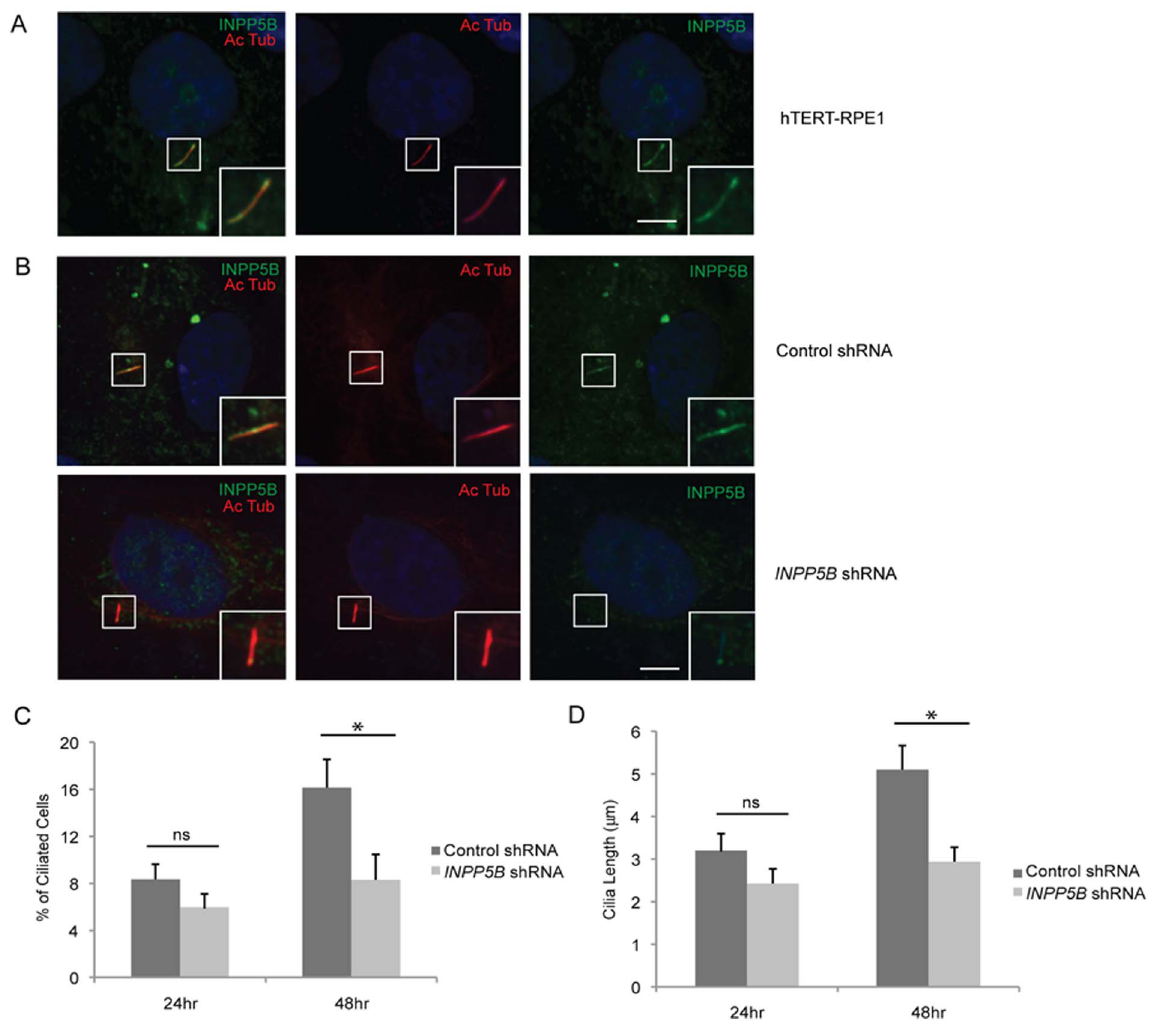
Figure 2. INPP5B localizes to primary cilia. (A) hTERT-RPE1 cells were starved for 48 hr, and analyzed by immunostaining with anti-INPP5B antibody and anti-acetylated alpha-tubulin antibody. Scale bar 5 micron. (B) Control and INPP5B shRNA hTERT-RPE1 cells were starved for 48 hr, and analyzed by immunostaining with anti-INPP5B antibody and anti-acetylated alpha-tubulin antibody. Scale bar 5 micron. (C-D) Control and INPP5B shRNA hTERT-RPE1 cells were starved for 24 hr or 48 hr, and analyzed by immunostaining with anti-acetylated alpha-tubulin antibody. Percent ciliated cells (C) and the length of cilia (D) were quantified. (n=the number of cilia n . 100 cilia, three independent experiments, unpaired t-test, * p=2.1E-08 in D, * p=3.1 E-09 in E; ns, not statistically